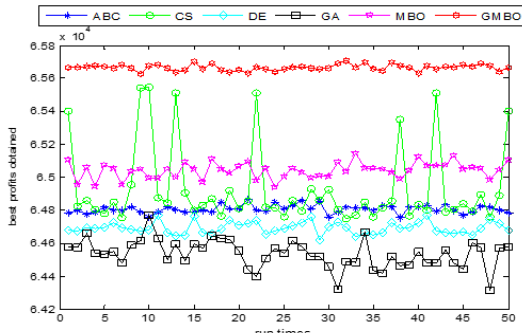
Figure 9. Comparison of the best values on KP9 in 50 runs.